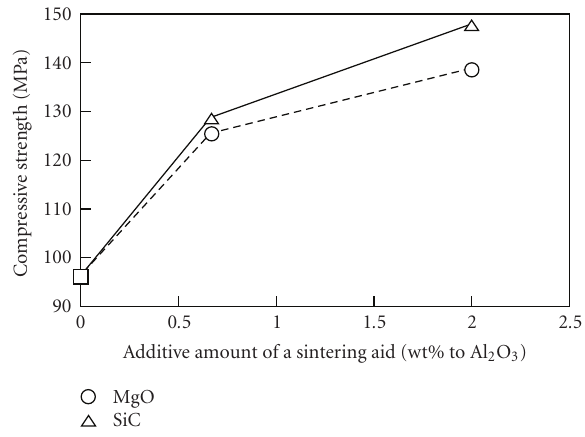
Figure 9: Variations in compressive strength of P m NONE and P m SA( n ) compacts fabricated with MR-20G PMMA microspheres as a template as correlated with the additive amounts of MgO or SiC used as a sintering